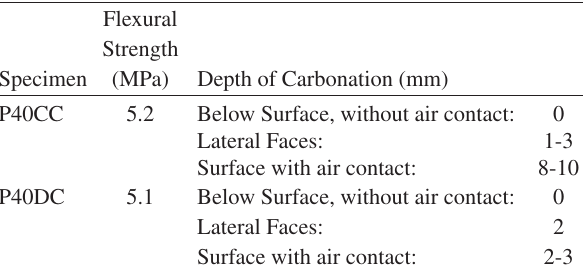
Table 4. Flexural Strength and Depth of Carbonation.